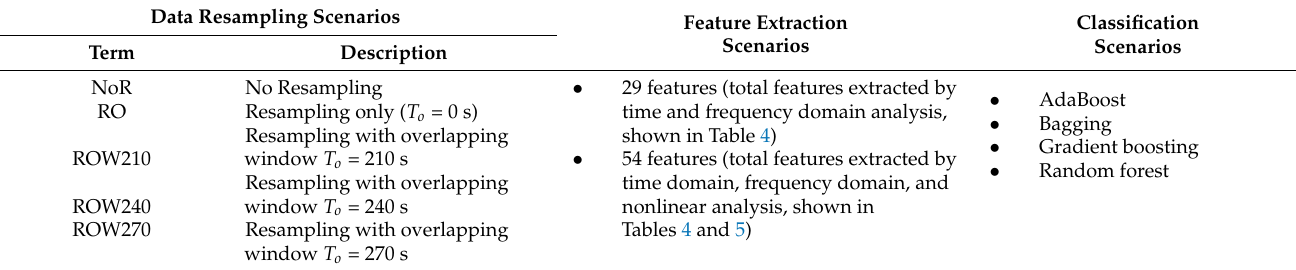
Table 7. Summary of all scenarios in the data resampling, feature extraction, and classification